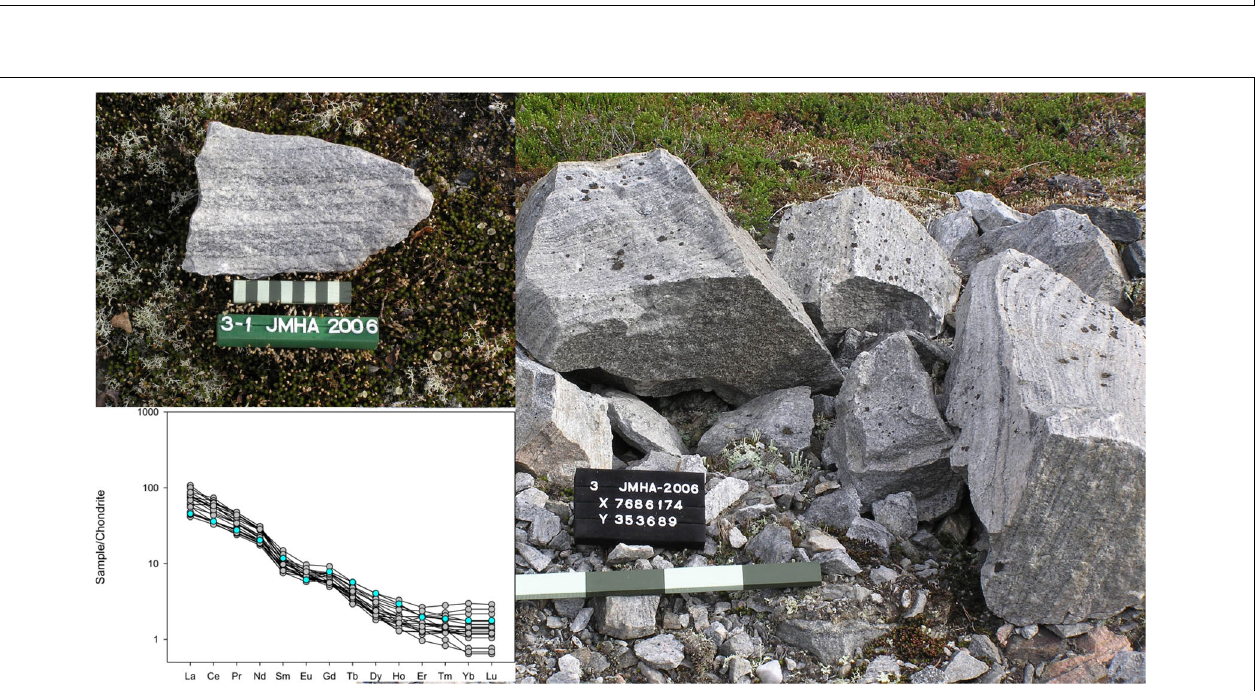
FIGURE 14 | Left: REE patterns of low-HREE TTGs from the Lake Inari Complex ( Supplementary Table S1 ). The pattern indicated by blue symbols is from a diatexite sample found in the same Näätämö area as metatexite sample in Figure 15 . Length of scale: hand specimen 10 cm, outcrop 40 cm.